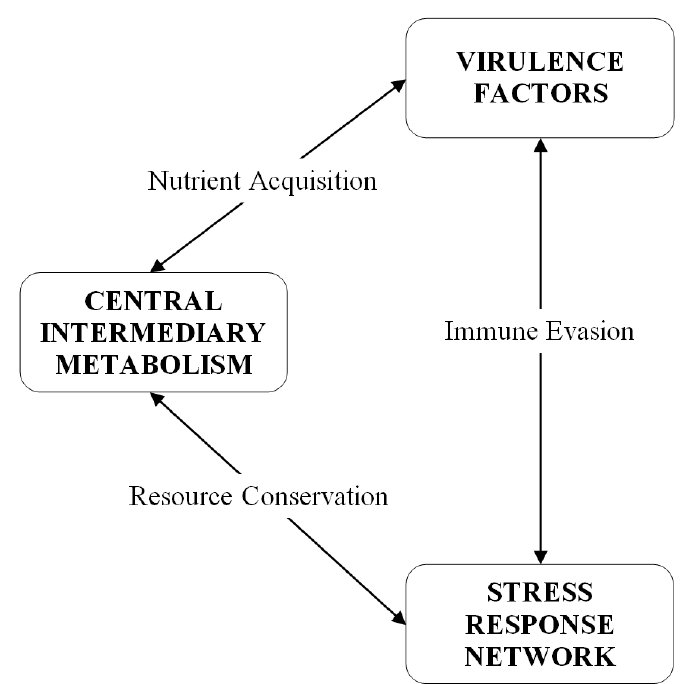
Figure 3. Conceptual diagram of the relationship between central intermediary metabolism, virulence factors, and the stress response network. Virulence is related to central intermediary metabolism through the production of soluble exoprotein virulence factors, regulated in a cell density-dependent fashion, which destroy host tissue in order to make nutrients available to a growing bacterial population. Cell-associated virulence factors are primarily defenses against host immune responses, working in conjunction with stress responses to immune system oxidative insults and damage sensing and responses to cell wall-active antibiotics. The stringent response is a stress response that coordinates a downregulation of central intermediary metabolism, and protein and nucleic acid synthesis, in order to conserve resources during periods of nutritional